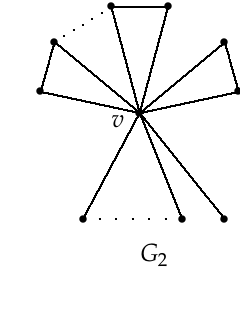
Figure 2. Graphs G 1 and G 2